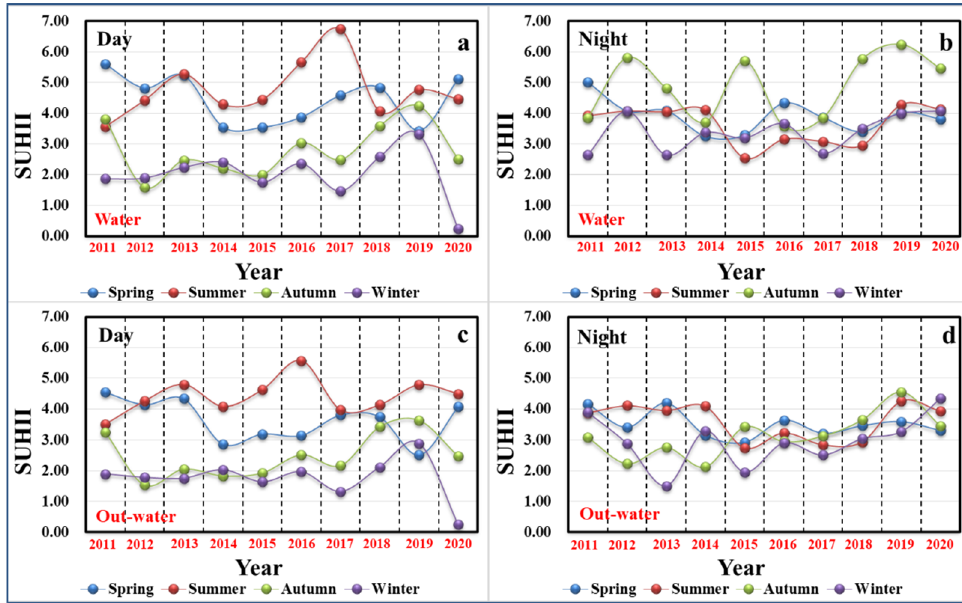
Figure 5. Diurnal and seasonal SUHII of Hefei from 2011 to 2020 (( a , b ) are the SUHII during daytime and nighttime in different years, respectively; ( c , d ) are the SUHII during daytime and nighttime in different years under the excluded water, respectively).